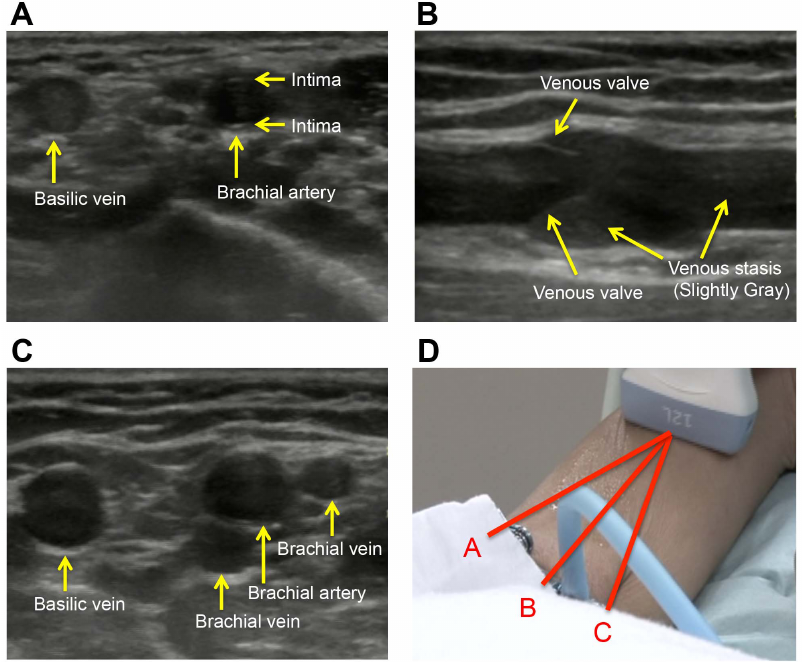
Figure 4. How to distinguish the artery and vein. ( A ) Typical appearance of artery. An artery is rounded, pulsing, and accompanied by thin high brightness of the intima beneath the adventitial circle. ( B ) Venous stasis and valve. Gray slightly high-echoic venous stasis is seen in the lumen and, depending on the site, in venous valves. ( C ) Typical cross-section view of the upper arm. A brachial artery, two accompanying brachial veins, and a basilic vein located medially far from the others are shown. ( D ) Imaging the vessel course pattern by sweeping. If the vein runs as B, its section will stay at the center of the monitor during sweeping. If the vein runs as A or C, it will move to the left or right on the monitor during sweeping. In this case, turn the probe orthogonal to the line (A or C). After imaging and adjustment, a 90 u turn of the probe will result in a clear longitudinal view of the vein.